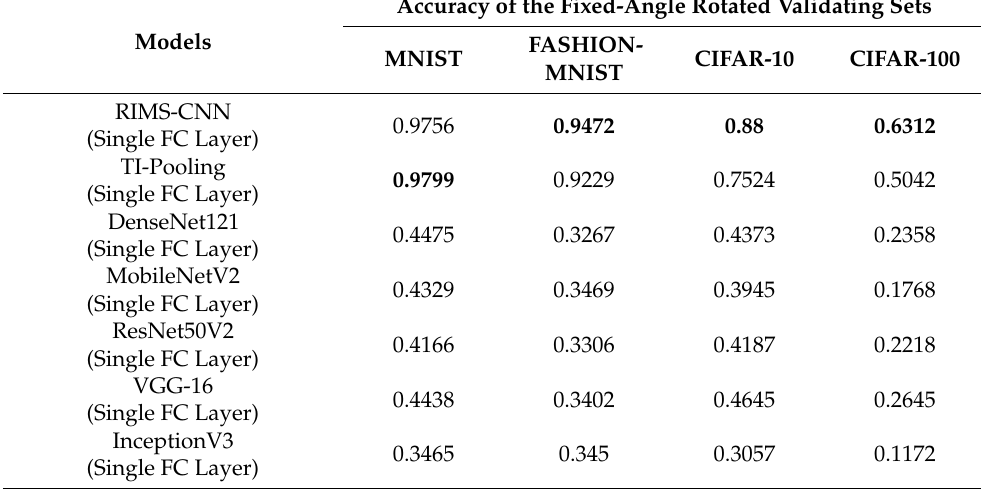
Table 4. Evaluating models on the original training sets and the fixed-angle rotated validating sets.